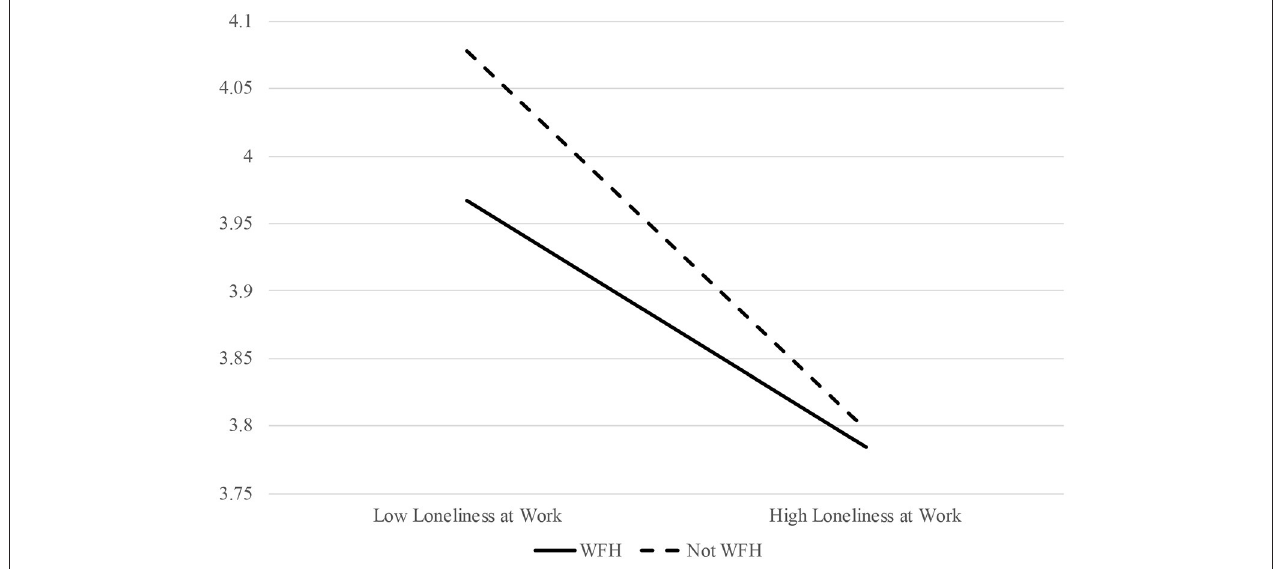
FIGURE 4 | The interactive effect of workplace loneliness and working from home (WFH) on